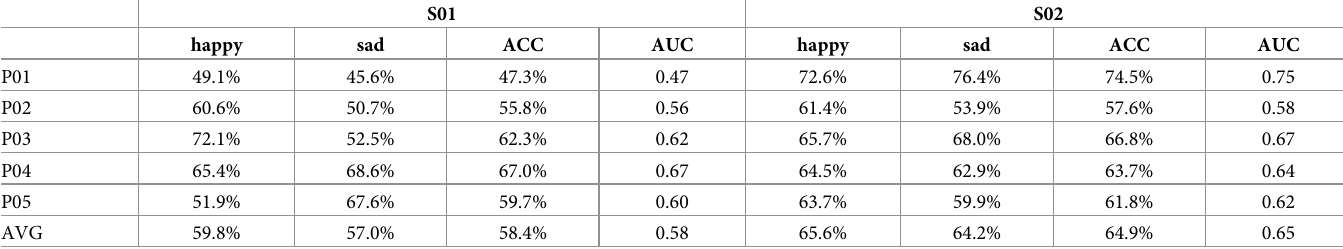
Table 2. Offline model performance results. Offline model performance based on 100-times-10-fold cross-validation for all subjects (P01-P05) and sessions (S01 and S02). Offline decoding performance is expressed in form of percentage of correctly classified observations per class (happy and sad), overall correctly classified instances (ACC) and via the area under receiver operator curve